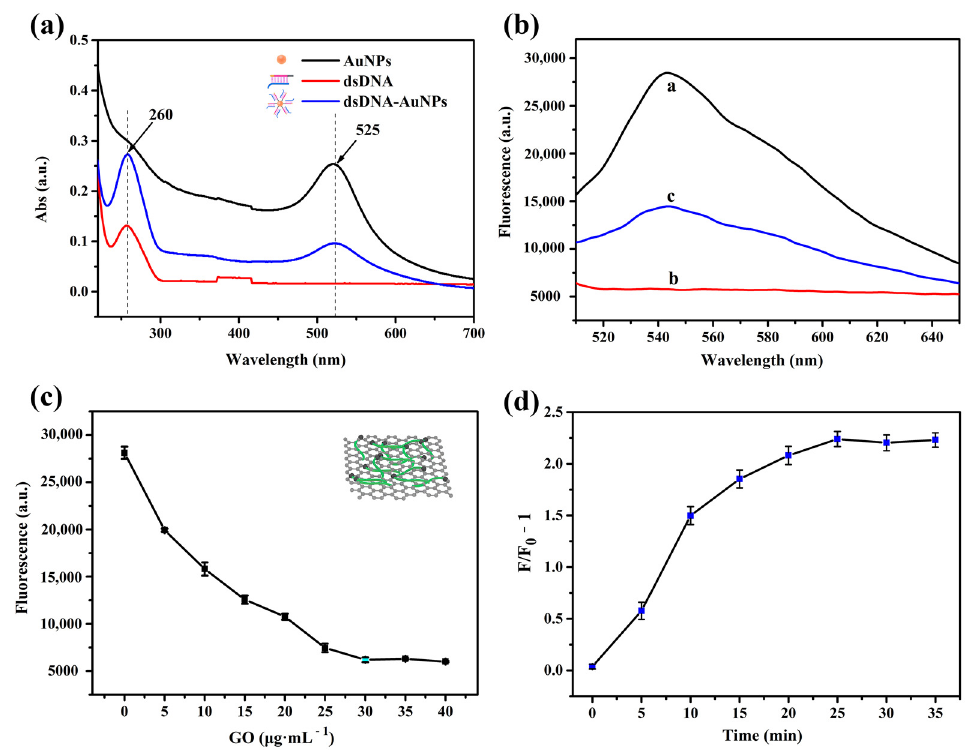
Figure 2. ( a ) Characterization of AuNPs, dsDNA, and dsDNA-AuNPs by UV–vis absorption spec- troscopy. The concentration of AuNPs was slightly greater than that of dsDNA-AuNPs to make the difference between the curves obvious. ( b ) Fluorescence emission spectra of fuel DNA (50 nM) under different conditions: ( a ) fuel DNA-CDs in PBS; ( b ) fuel DNA-CDs + 30 µ g/mL GO; ( c ) fuel DNA- CDs + 30 μ g/mL GO + 1 nM let-7a in the presence of dsDNA-AuNPs (excitation: 488 nm, emission: 543 nm). ( c ) Fluorescence quenching of CDs labeled on the fuel DNA in the presence of GO at dif- ferent concentrations. ( d ) Effects of the reaction time of two TSDRs on the F/F 0 − 1 value of sensor system. Conditions: microRNA let-7a, 1 nM.